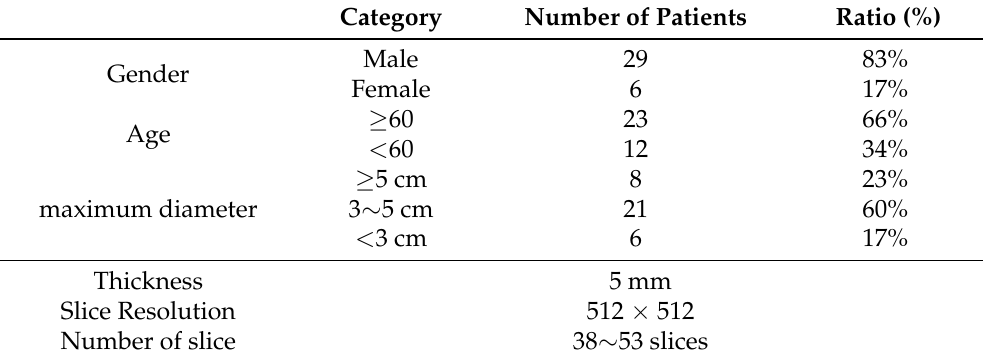
Table 1. Patient and data